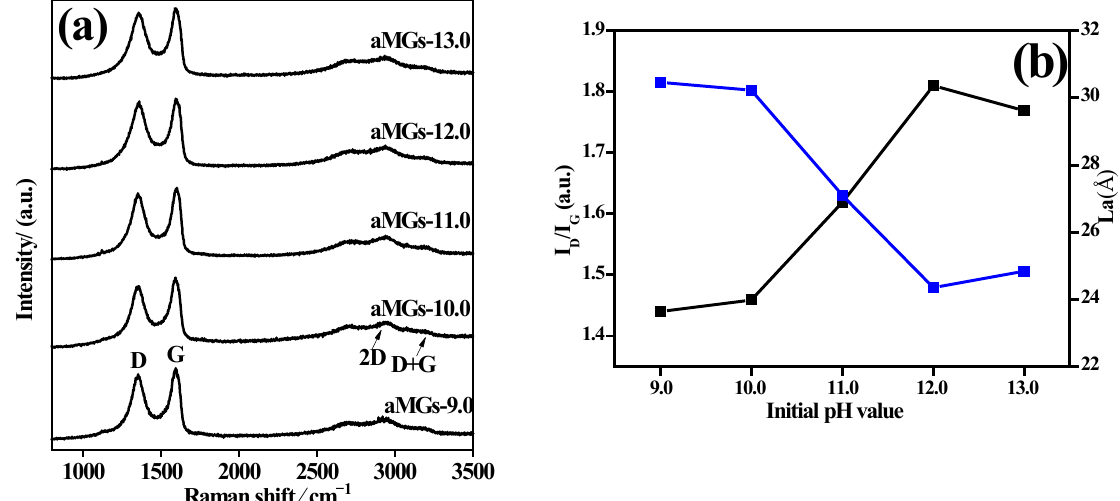
Figure 6. ( a ) The Raman spectra; ( b ) I D /I G (black) and L a (blue) of α MGs-X samples.